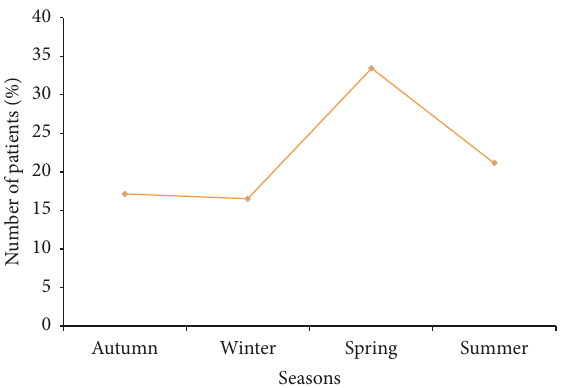
Figure 2: Seasonal evolution of fungal infections of the feet. Percentage of patients consulted during the four seasons.